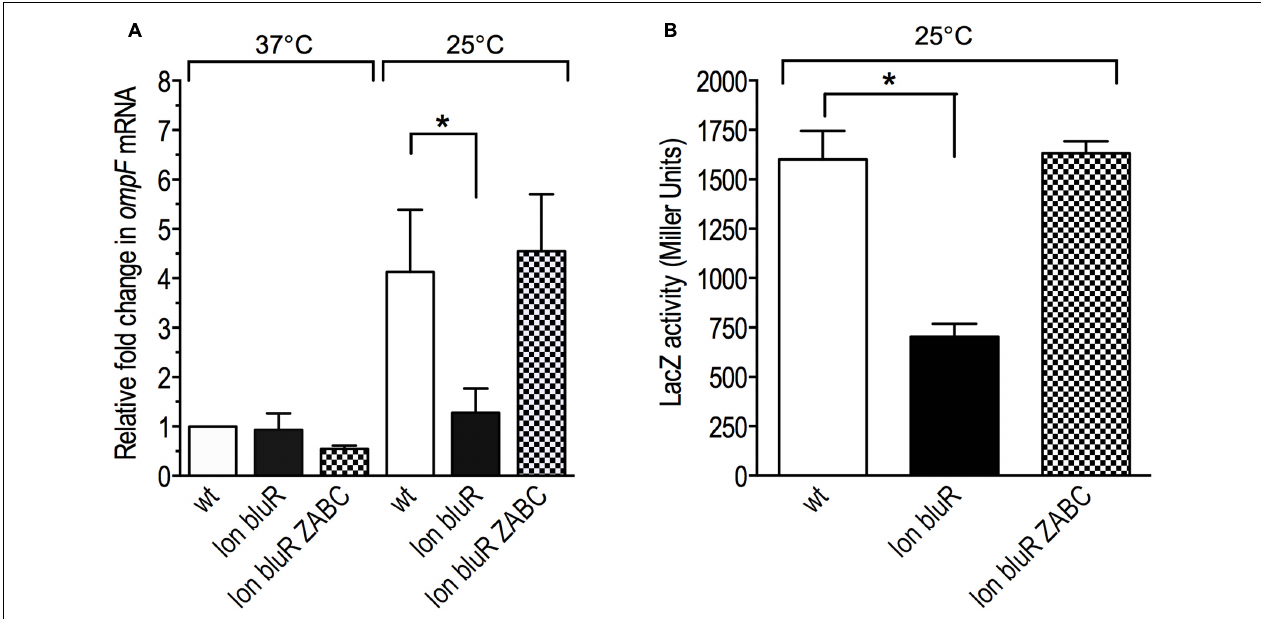
FIGURE 5 | lon and bluR mutations decrease ompF transcription via the ycgZ-ymgABC operon. The cells were grown to exponential phase (optical density at 600 nm ∼ 0.6) in LB medium at 25 and 37 ◦ C. Total RNAs were prepared and used to measure the OmpF mRNA levels by RT-qPCR. (A) Fold change in OmpF mRNA levels relative to the wild type strain grown at 37 ◦ C. (B) The β -galactosidase activity (Miller units) of a single chromosomal copy of P ompF-lacZ was measured for cells grown to exponential phase in LB medium at 25 ◦ C. wt, VDL25113; lon bluR , VDL102; lon bluR ycgZ-ymgABC (VDL104). The means and standard deviations of at least three independent experiments are shown. Statistically significant differences for a mutant compared to wild type are shown as asterisk ( ∗ P < 0.05). See Supplementary Table S6, S7 for details.